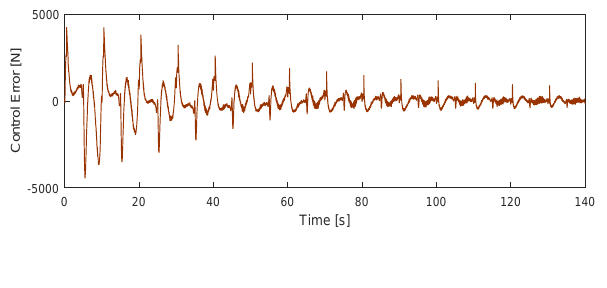
Figure 20: Initial convergence of the ILC.